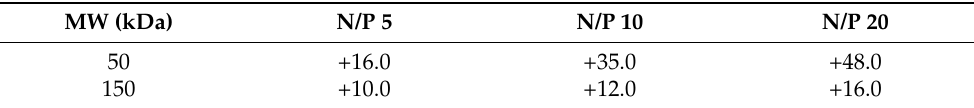
Table 4. Z-potential (mV) of CS/hsDNA complexes prepared with CS of different molecular weights and at different N/P